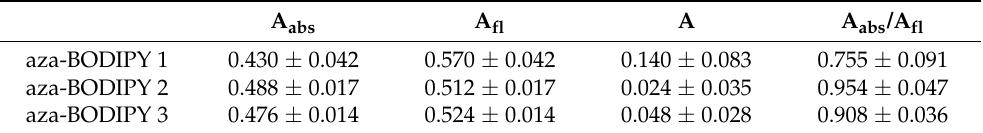
Table 4. Solvatochromic sensitivity parameters.